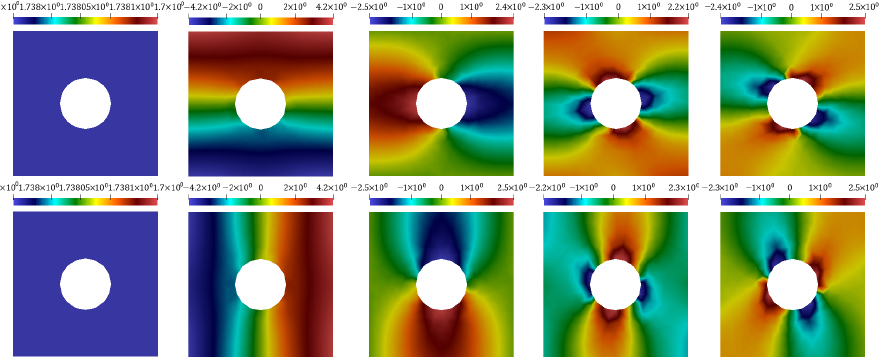
Figure 6. Illustration of the perforation boundary multiscale basis functions for elasticity problem, ψ i for k = 1, . . . ,5 (from left to right ). First row: displacement X - component. Second row: p , k displacement